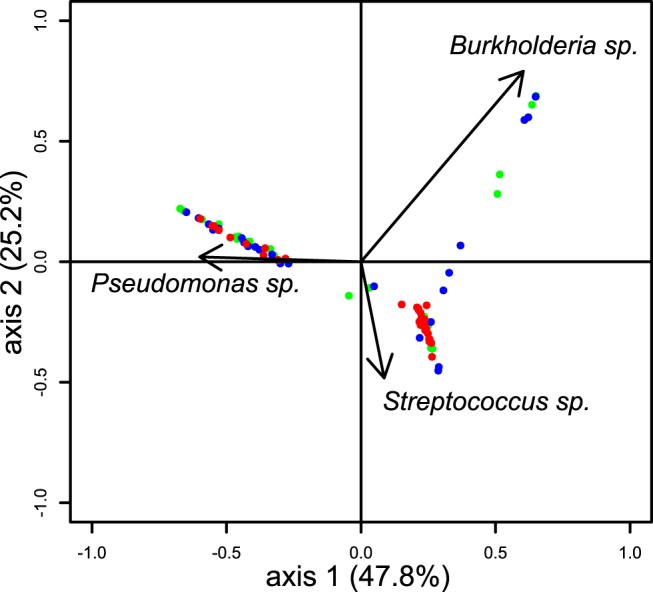
Principal Component Analysis of sputum samples from children and adult patients CF patients.Sputum samples from children with CF are represented by red points and adult CF patients by blue (at the time of admission in the clinic) and green points (after antibiotics treatment). Pearson correlations were performed to highlight which genera were responsible for the divergence among the samples. Correlation was considered significant when the coefficient of correlation was higher than 0.6 and p-value < 0.01.